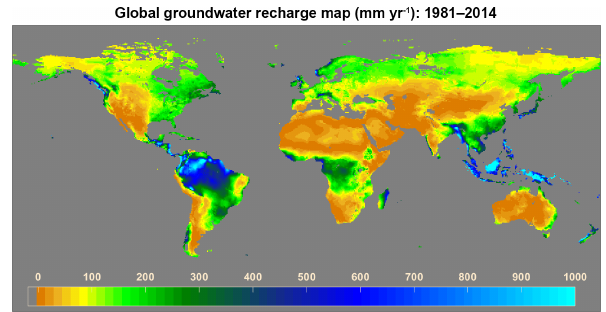
Figure 8. Long-term (1981–2014) average annual groundwater recharge estimated using the developed